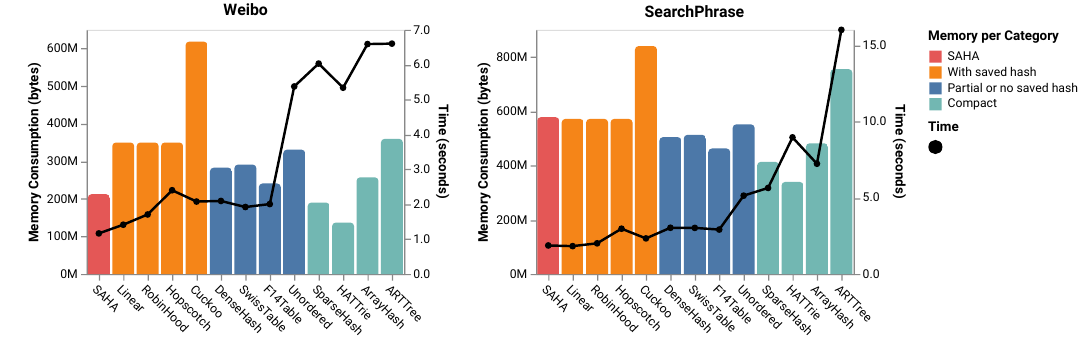
Figure 10. A combined bar and line graph of the memory and time consumption of various hash tables for group benchmarks on two datasets with short and long string length distributions (Weibo and SearchPhrase). The bar graph is grouped by memory consumption characteristics.